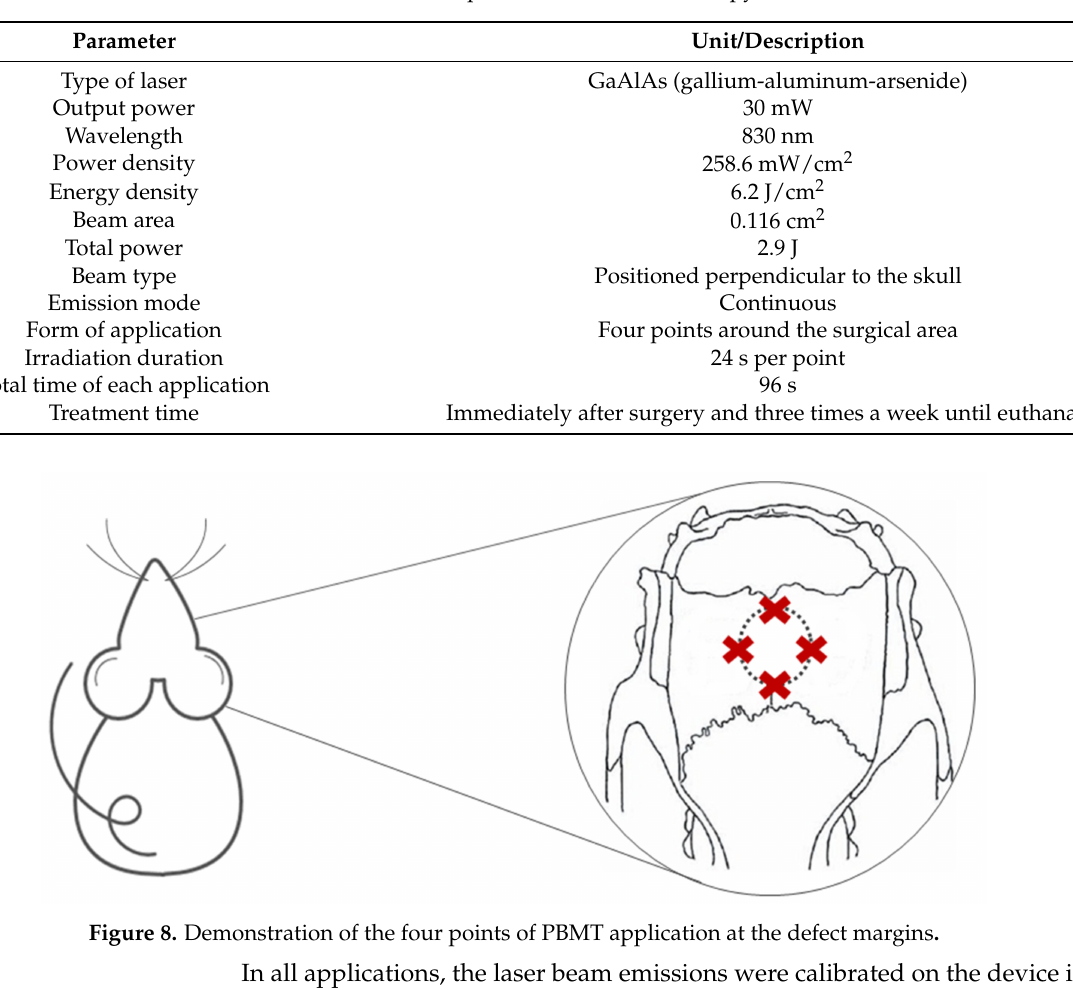
Table 2. Protocol of photobiomodulation therapy.